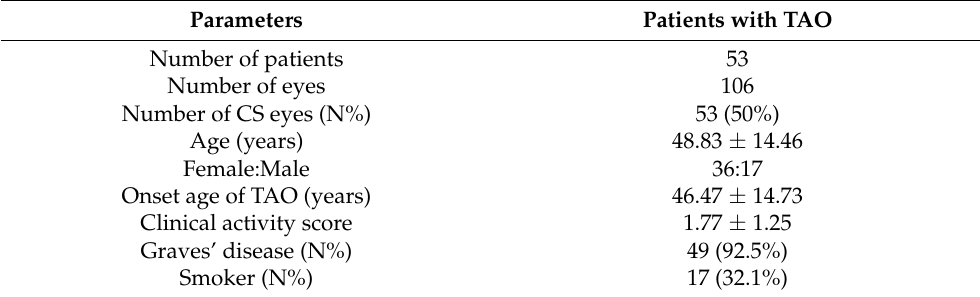
Table 1. Demographic characteristics of 53 TAO patients with unilateral corneal striae.